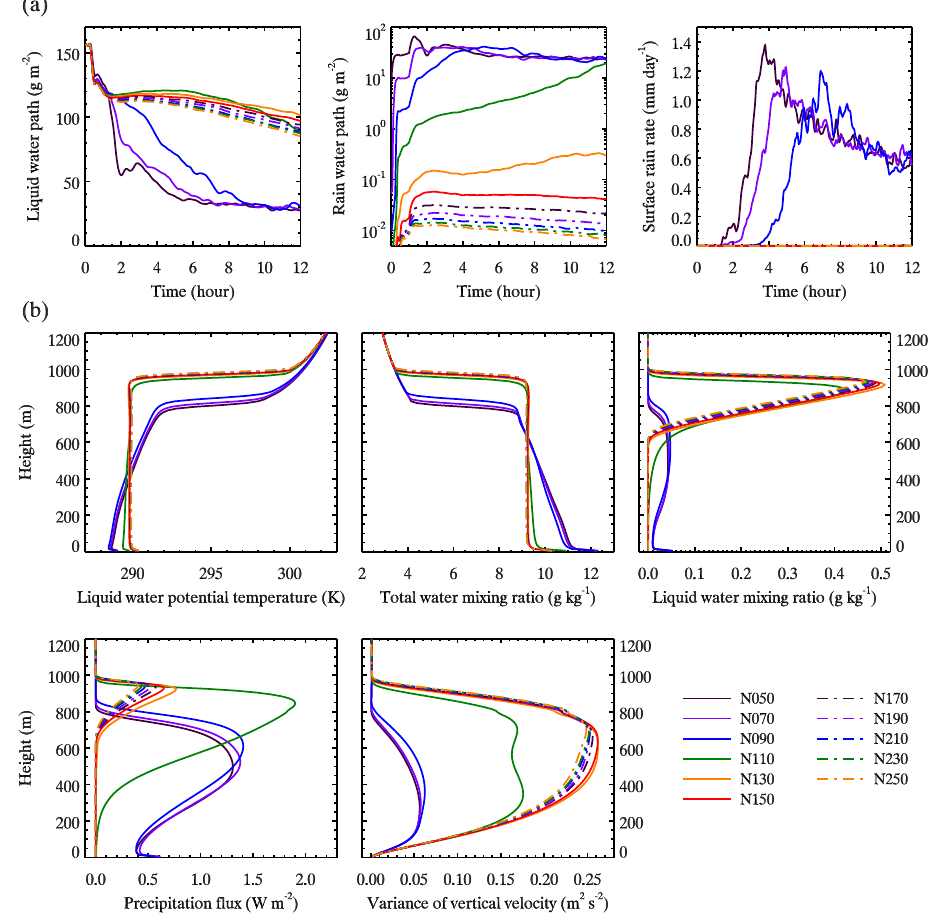
Figure 3. Domain mean statistics for S1. The vertical profiles are averaged over the last